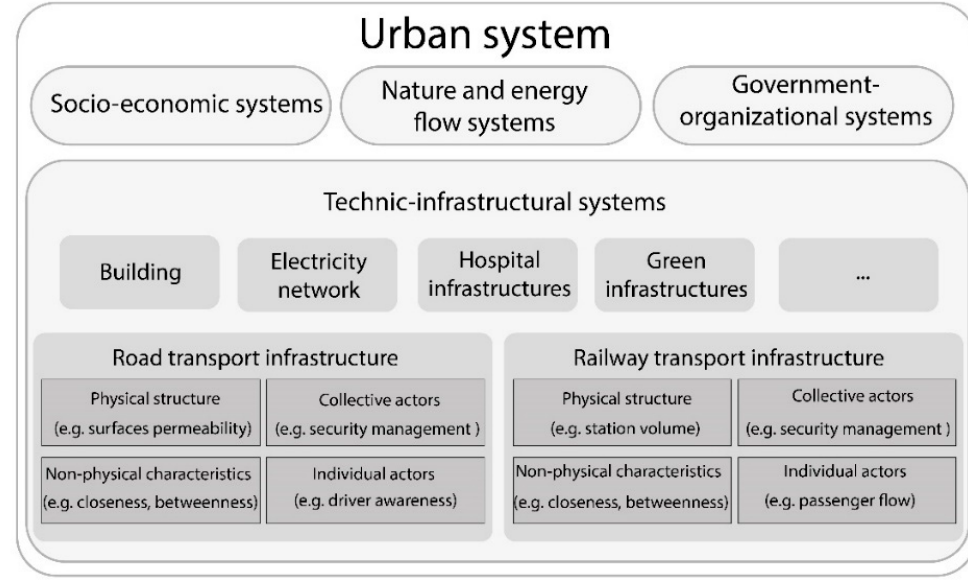
Figure 2. Internal and external systems of TIs, inspired by Yang et al. [36].